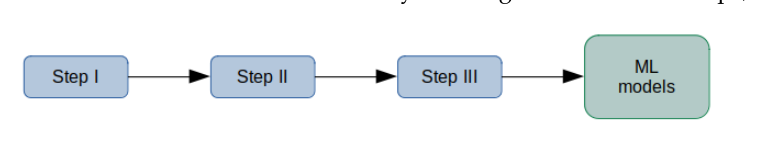
Figure 16. Steps of implementation of research related to